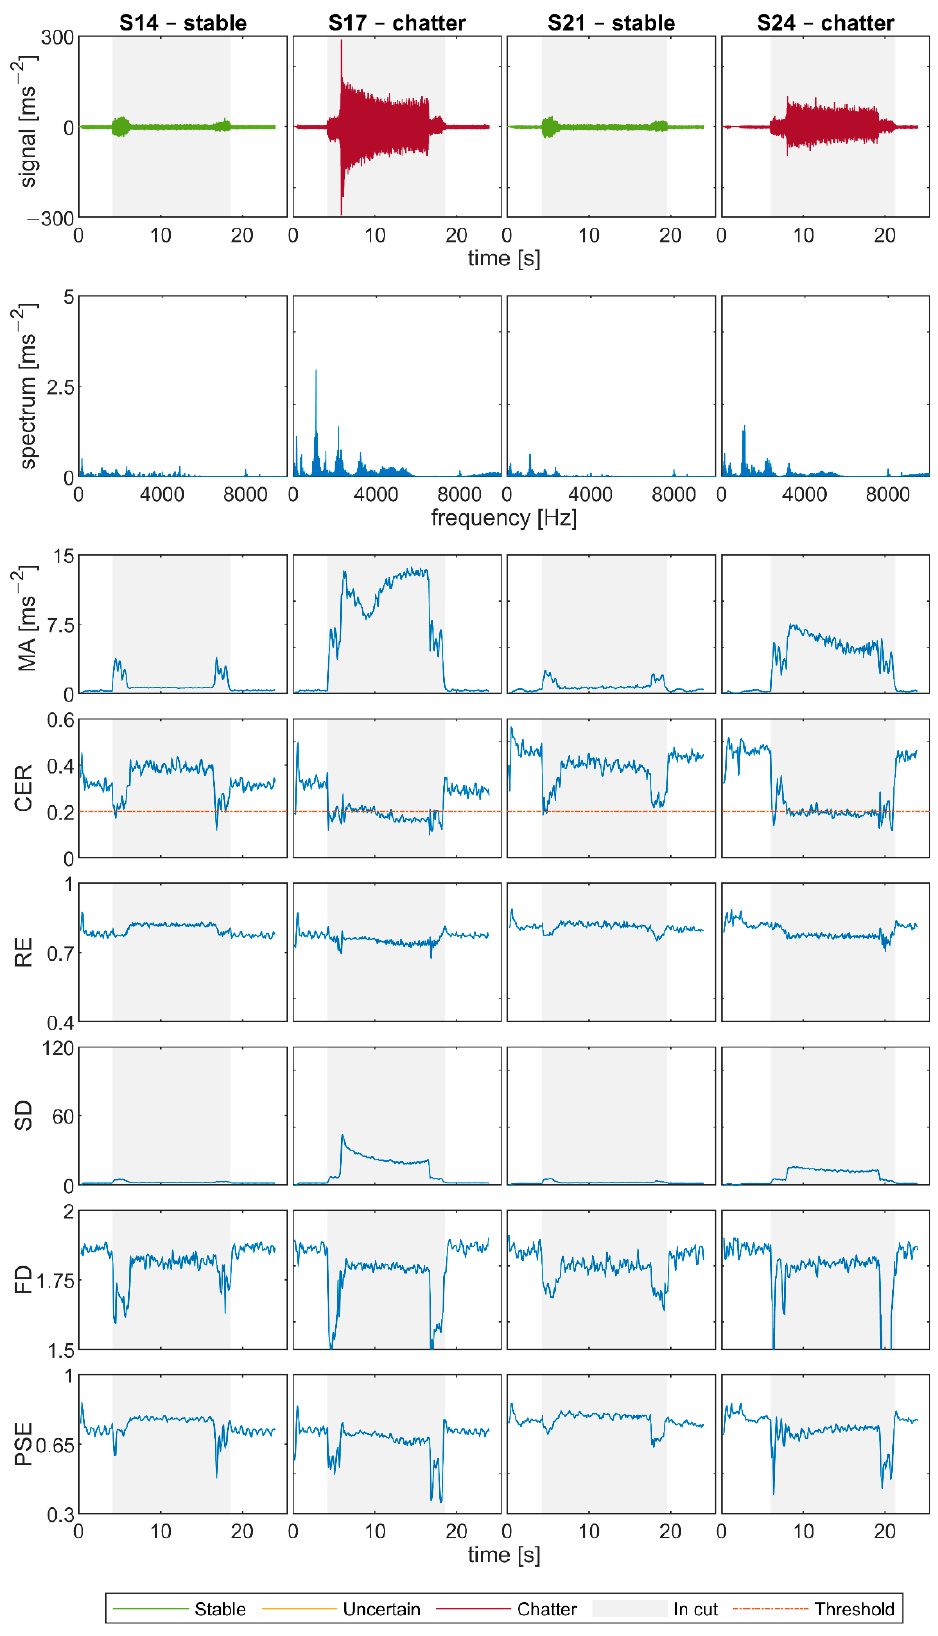
Figure 12. Signals from Experiment 3, shoulder mill. Stable signals S14, S21, chatter in signals S17, S24.